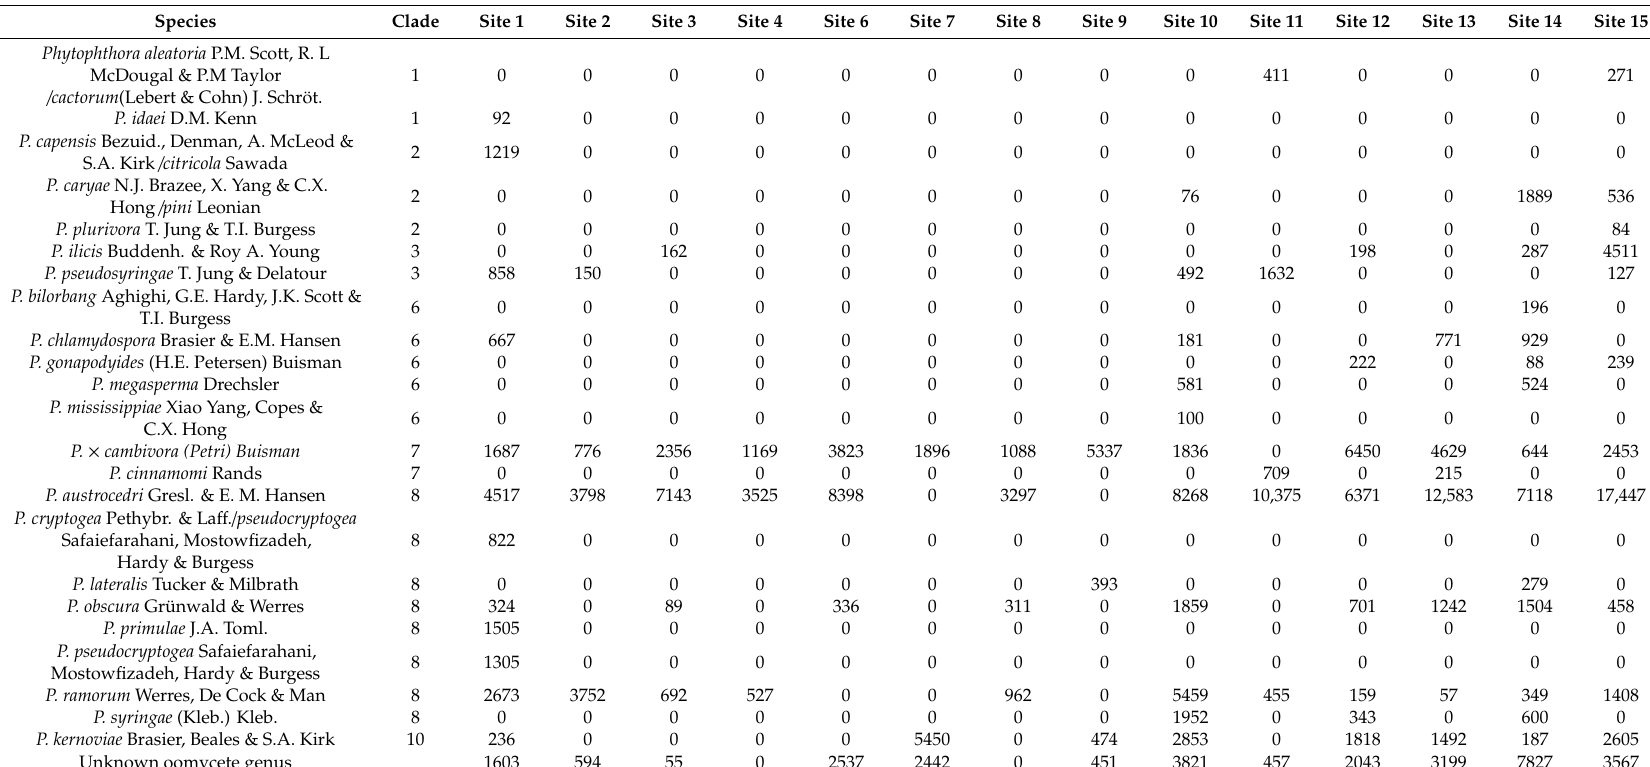
Table 2. Read counts per site and assigned species. The number of samples varied from two to six per site (see Table 1). Species Clade Phytophthora aleatoria P.M. Scott, R. L McDougal & P.M Taylor / cactorum (Lebert & Cohn) J.